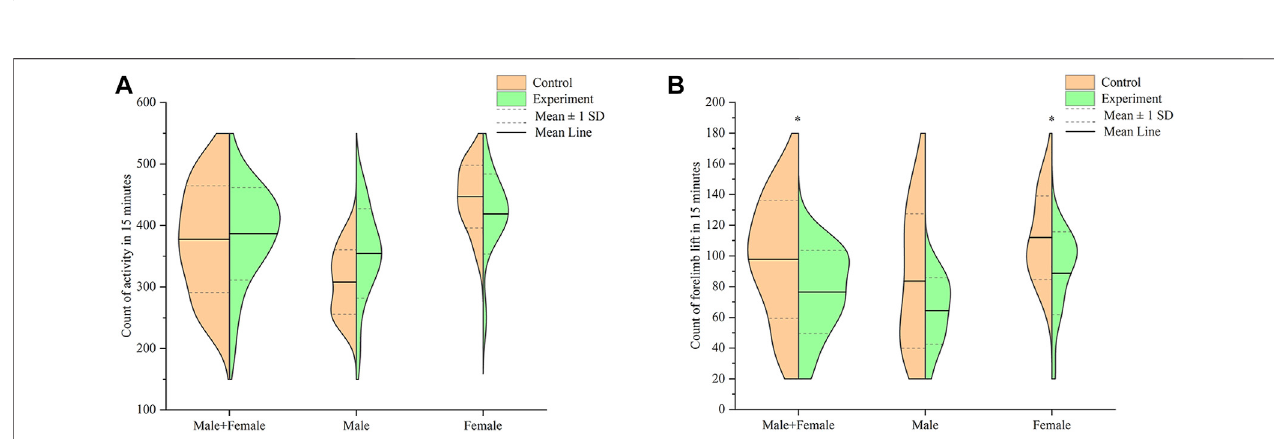
FIGURE5| EffectofHp-associatedchronicgastritisonautonomousactivityinmice. (A) SplitviolinplotshowingtheeffectofHp-associatedchronicgastritisonthe count of activity; (B) Split violin plot showing the effect of Hp-associated chronic gastritis on the count of forelimb lift. * p < .05 versus control.